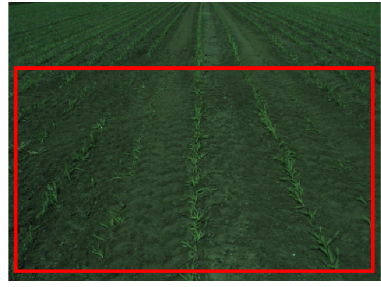
Figure 5. Initial reference region